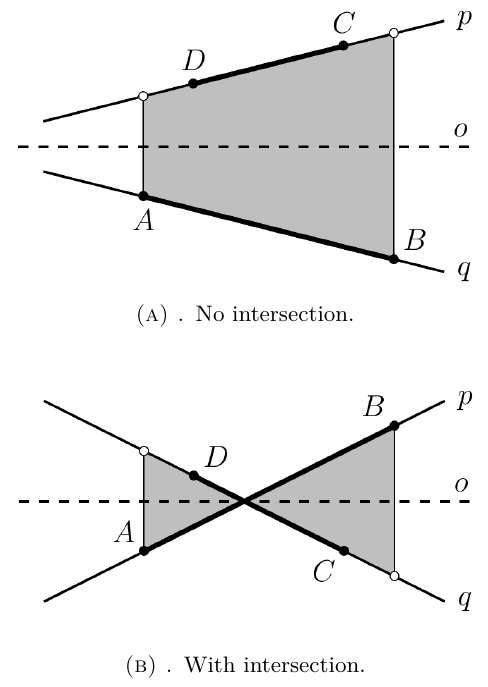
Figure 3. Line segments similarity criterion. The smaller is the gray area, the more similar are both line